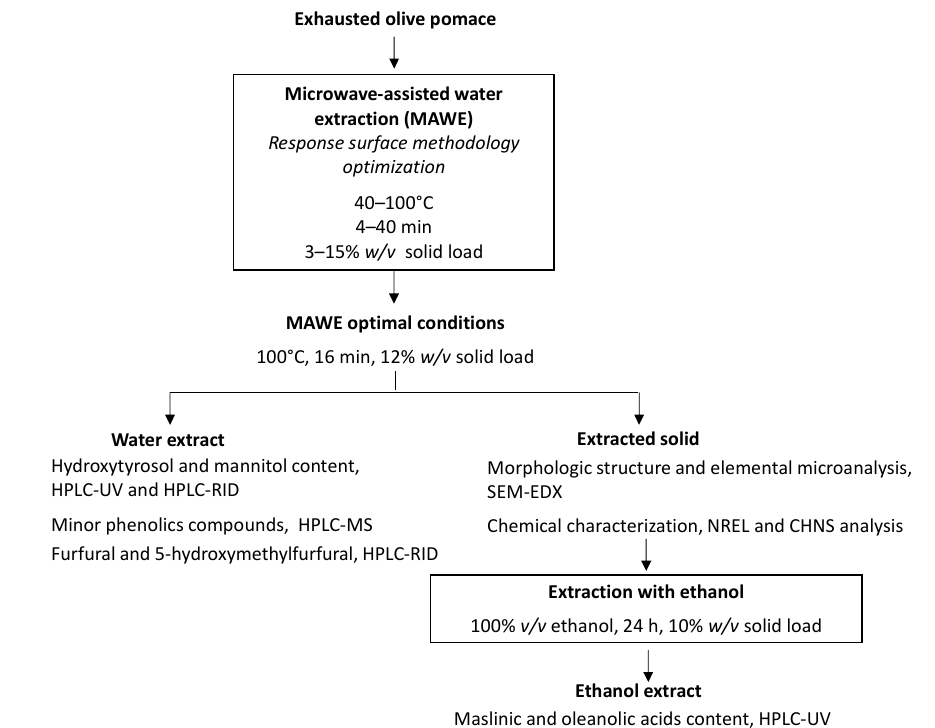
Figure 1. Experimental methodology followed in the present study.